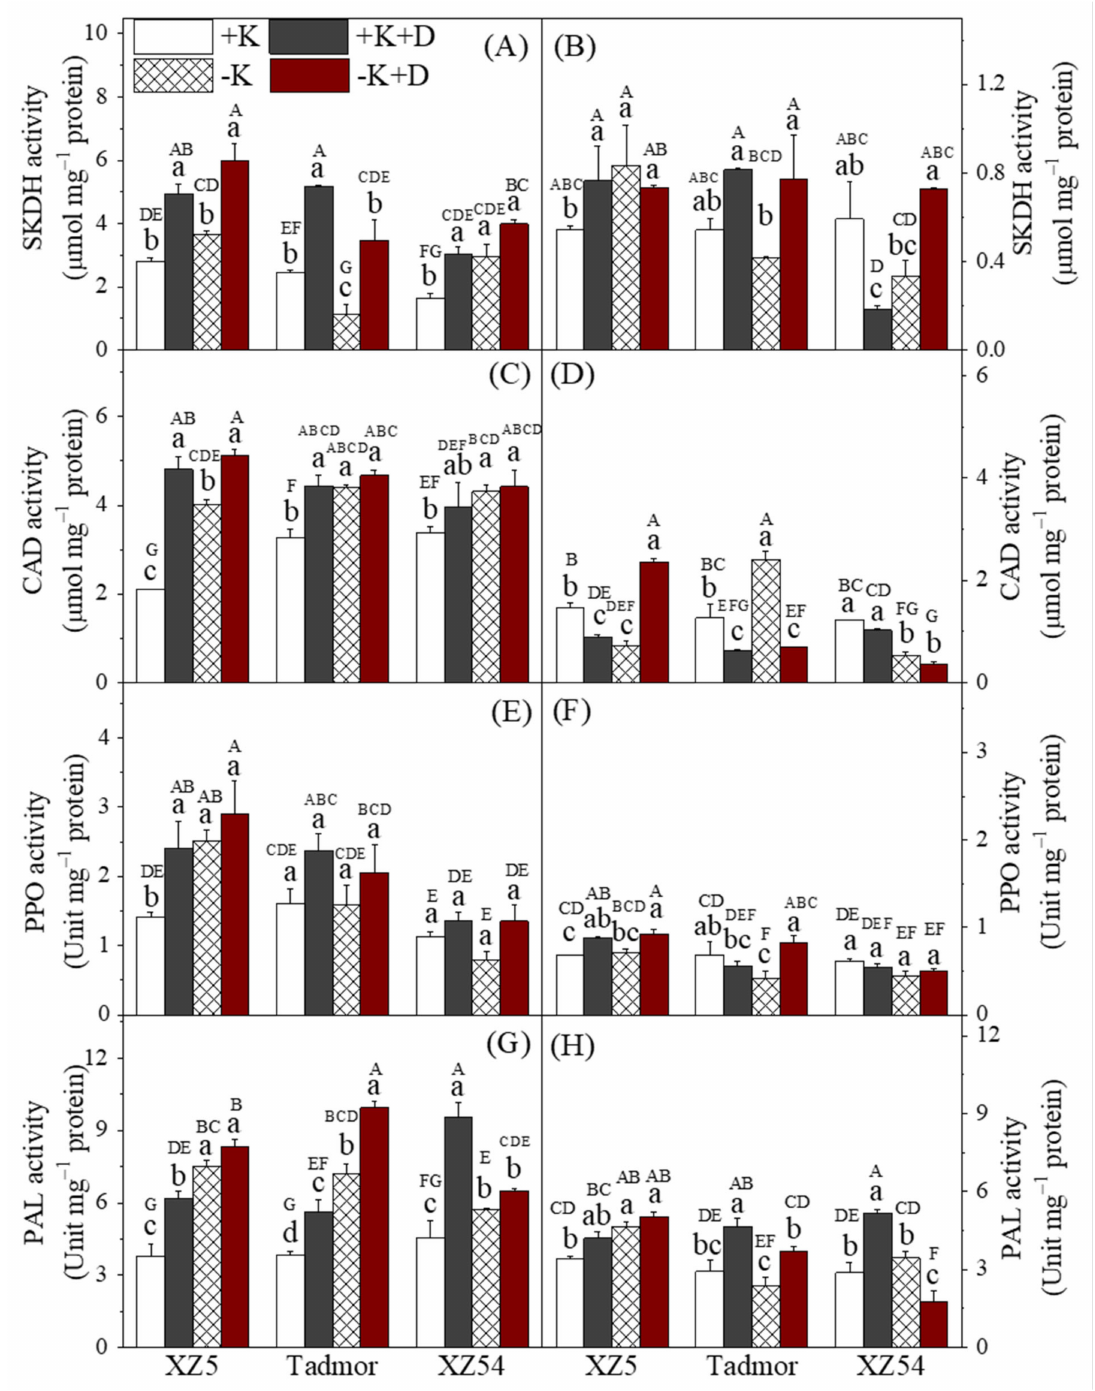
Figure 3. Effect of alone and combined stress of drought and K+ deprivation on secondary metabolism-related enzymes PAL, PPO, CAD and SKDH activities in leaves ( A , C , E , G ) and roots ( B , D , F , H ) of three barley genotypes. Different capital and small letter(s) indicate significant differences ( p < 0.05) among the genotypes and among the 4 treatments within each genotype, respectively. +K, +K+D, –K, and –K+D, correspond to basic nutrition solution with normal K of 1 mM K (BNS), BNS + 20% Polyethylene glycol 6000 (PEG), BNS without K (K deprivation), and BNS without K + PEG, respectively. Error bars represent standard deviations ( n =